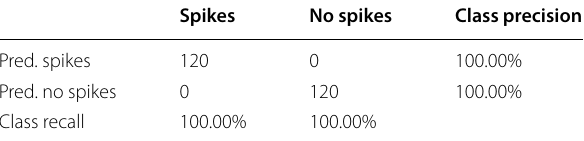
Table 4 Results of the evaluation of the Neural